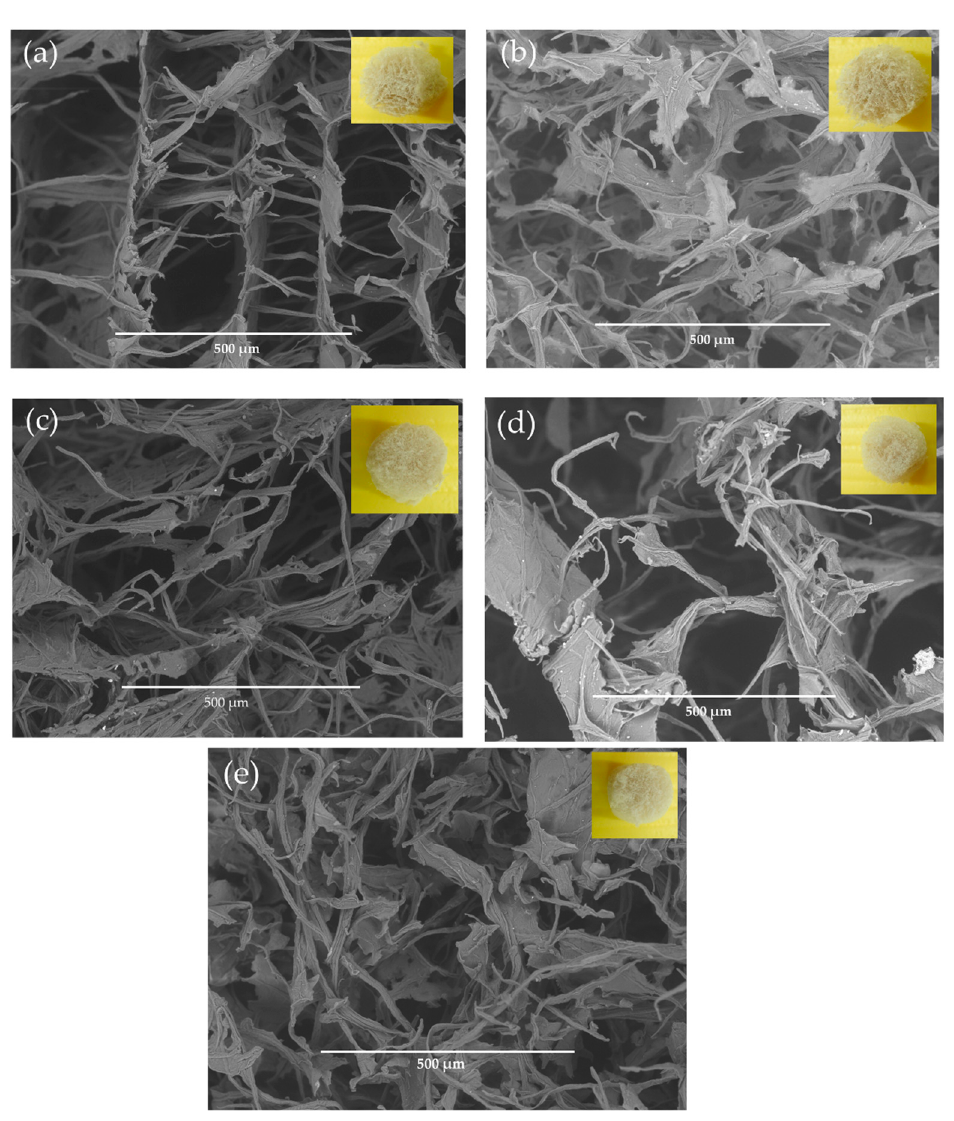
Figure 5. SEM analysis of aerogel-based CNC/CNF mixture ( a ) A-C/F 11 ; ( b ) A-C/F 12 ; ( c ) A-C/F 13 ; ( d ) A-C/F 21 ; ( e ) A-C/F 31. Various sizes and shapes of pores were observed between the sheets of the aerogel.